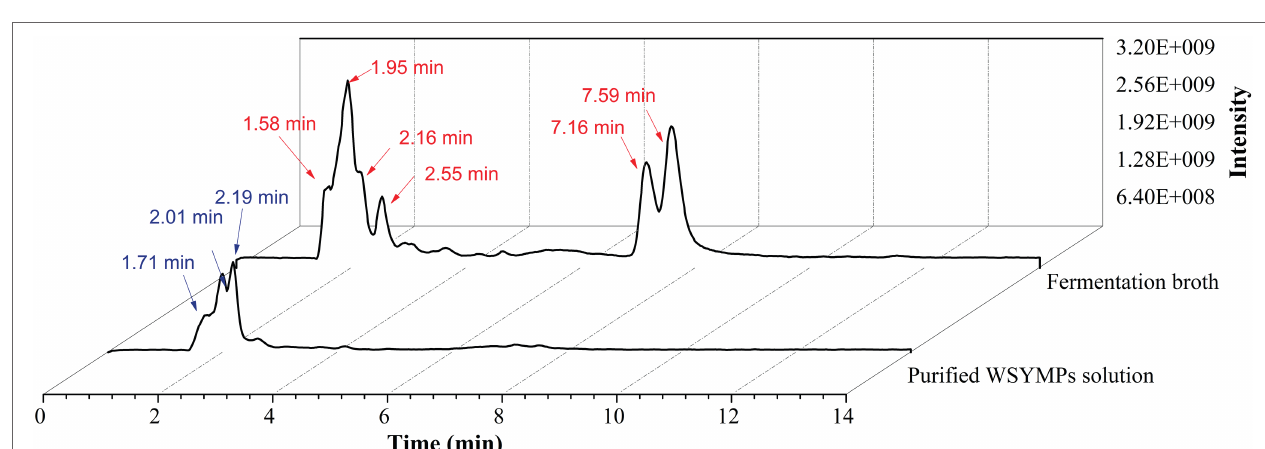
FIGURE 6 | The value stability of ankaflavin subject to pH (A) and light (B) .